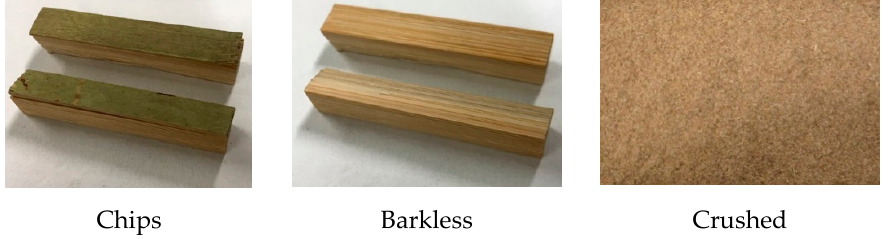
Figure 2. G. Angustifolia Kunth culm samples, prior to the calcium hydroxide treatment.